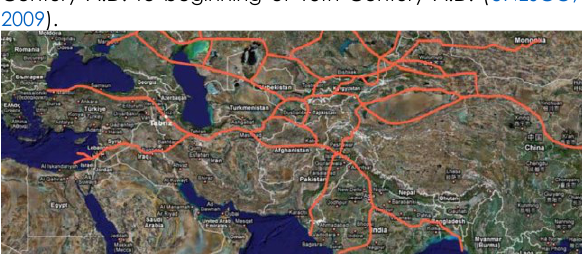
Figure 12. The Location of Tabriz on the Silk Roads from 13th Century A.D. to 16th Century A.D. (UNESCO,